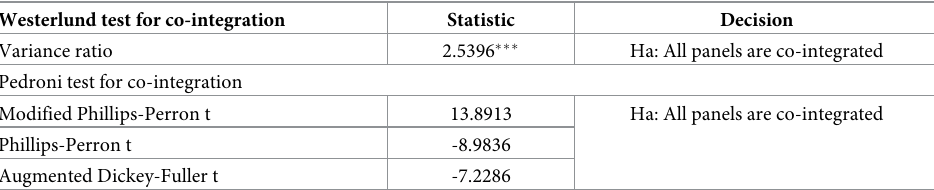
Table 4. Results of panel co-integration